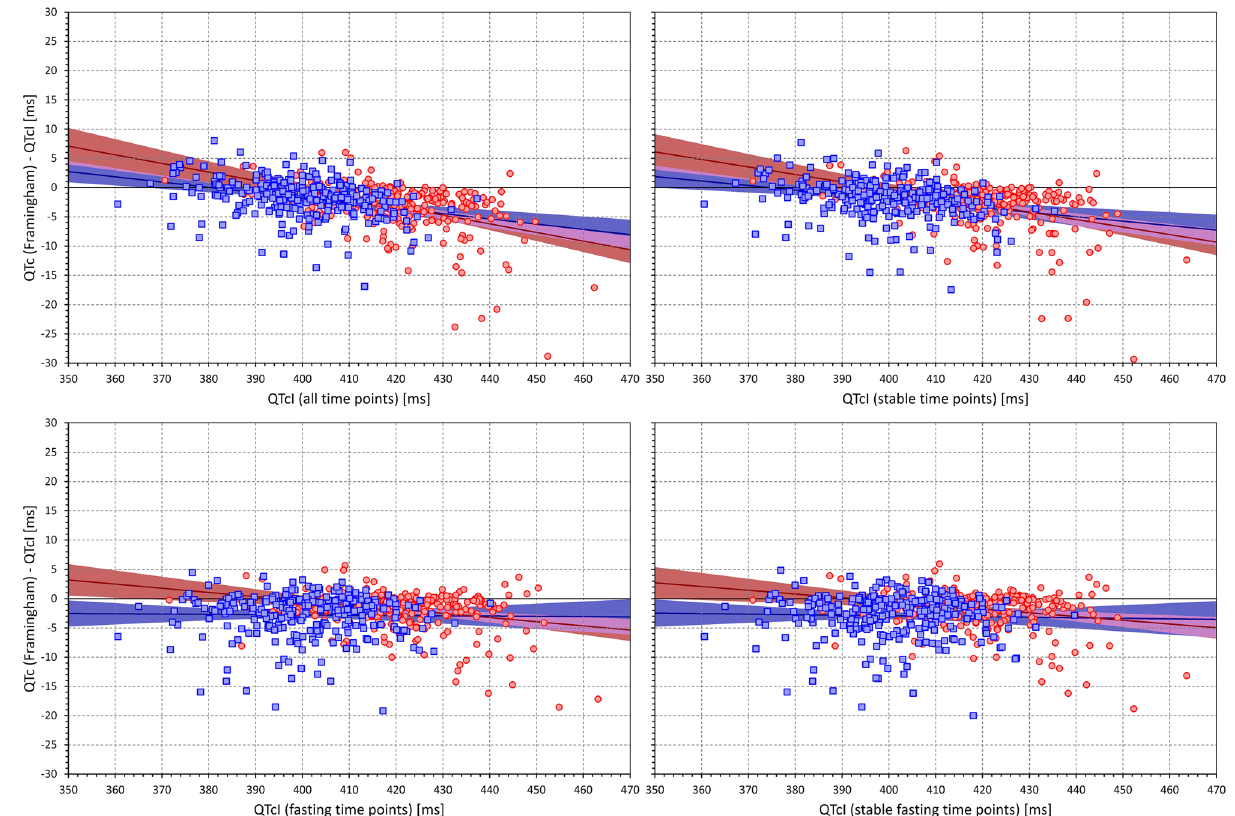
Figure 15. The figure meaning and layout correspond to those of Fig. 12 but instead Bazett QTc data, Framingham QTc data were